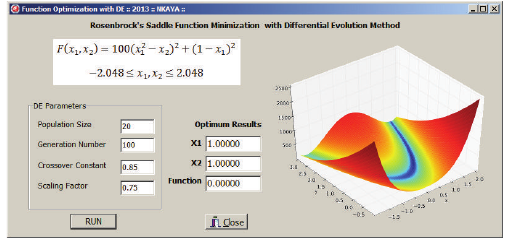
Figure 1: Optimization user interface and results for test function